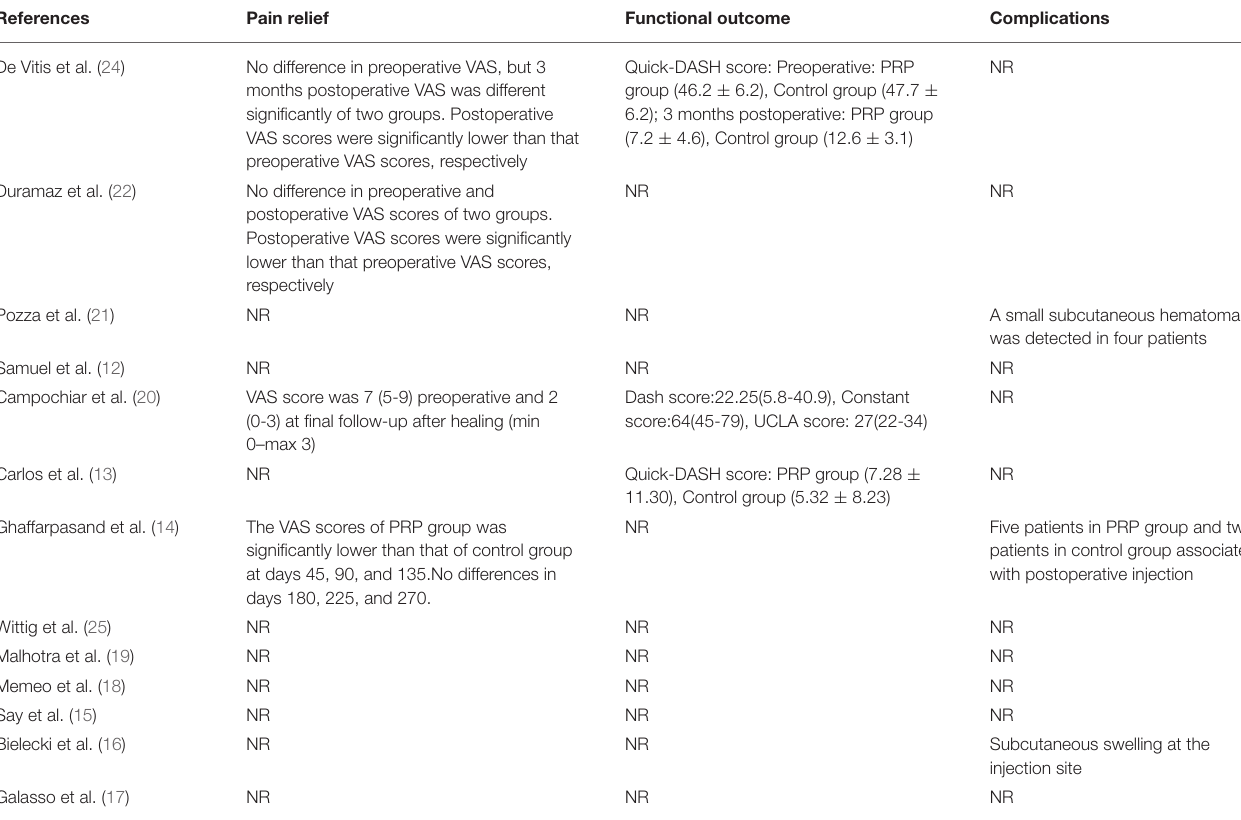
TABLE 6 | Pain relief, functional outcome, and complications of enrolled